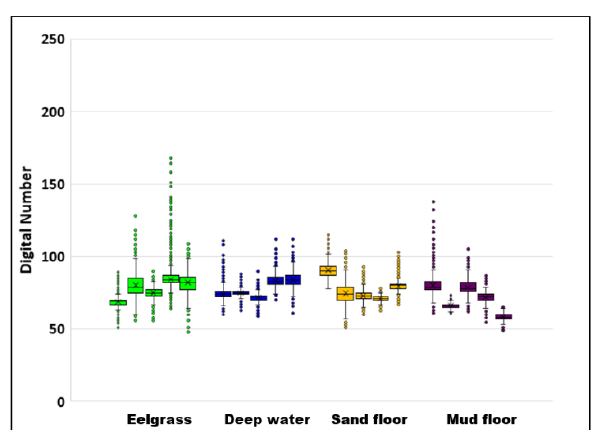
Figure 10. Channel 3 (red band) comparison of the DN values for the four classes in the PCI Geomatica RGB mosaic of Shediac Bay.